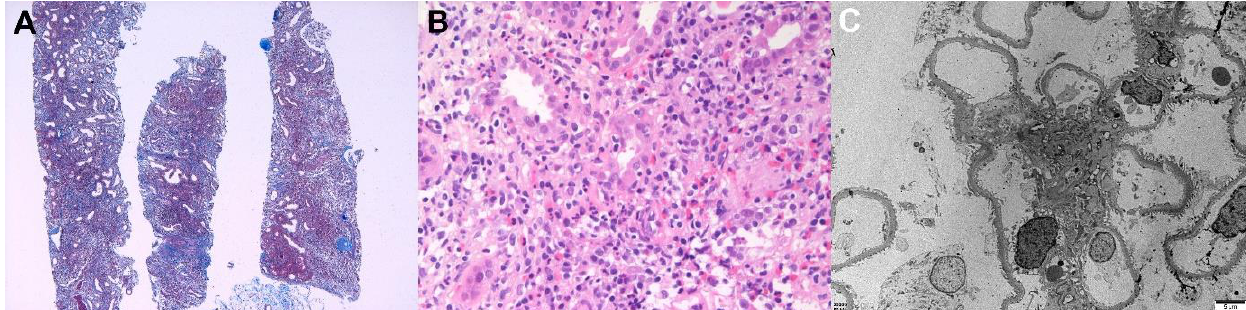
Figure 4. Pathologic findings of acute tubulointerstitial nephritis (patient 1). Light microscopy: ( A ) Massive interstitial inflammatory infiltrates with fibrosis (Masson’s trichrome, × 40) and ( B ) Mixed inflammatory cells infiltrated the tubular epithelium (tubulitis) and interstitium were observed. Large numbers of mononuclear cells, neutrophils, eosinophils, and plasma cells were present (hematoxylin and eosin, × 400). Electron microscopy: ( C ) The glomerulus showed a relatively normal appearance. No electron-dense deposits with a normal thickness of basement membrane and intact foot processes were present ( × 2500, 80